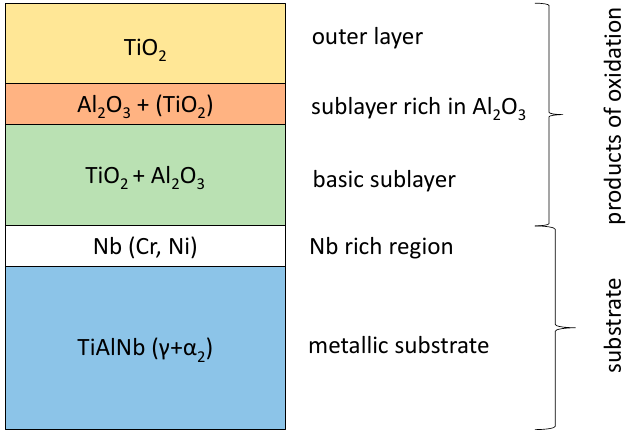
Figure 24. General structure of scale after oxidation of Ti-46Al-7Nb-0.7Cr-0.1Si-0.2Ni alloy.